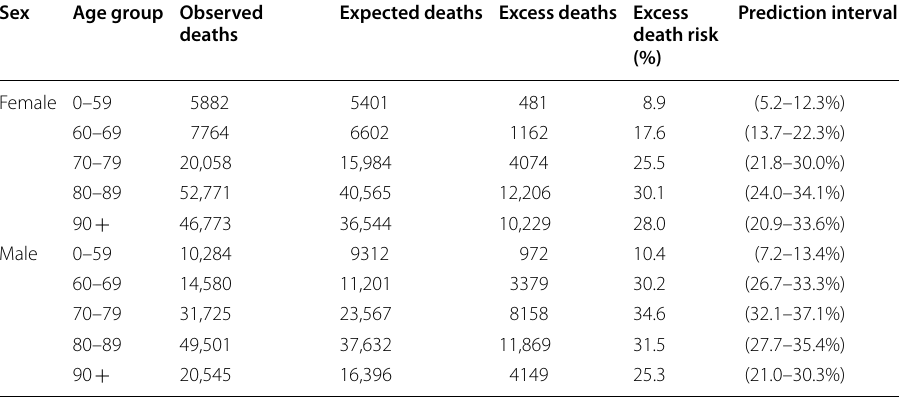
Table 1 Deaths (observed, expected, excess) and excess death risk by sex and 5 age group for Italy